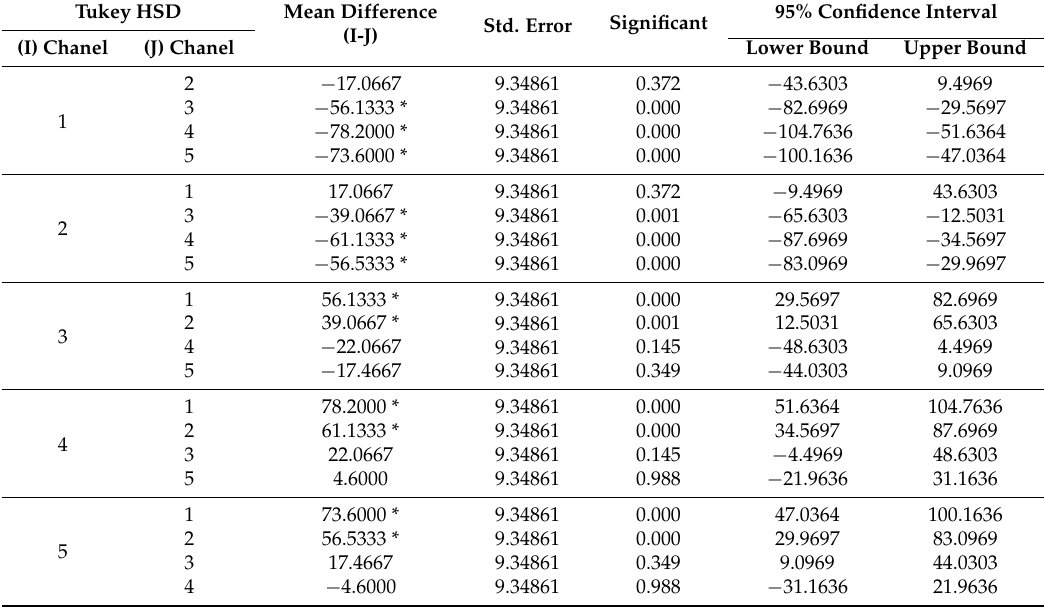
Table 5. Tukey post-test: Two significantly different groups are found, one consisting of channels 1 and 2, with lower roughness, and one with higher roughness, channels 3, 4, and 5. Tukey HSD Mean Difference